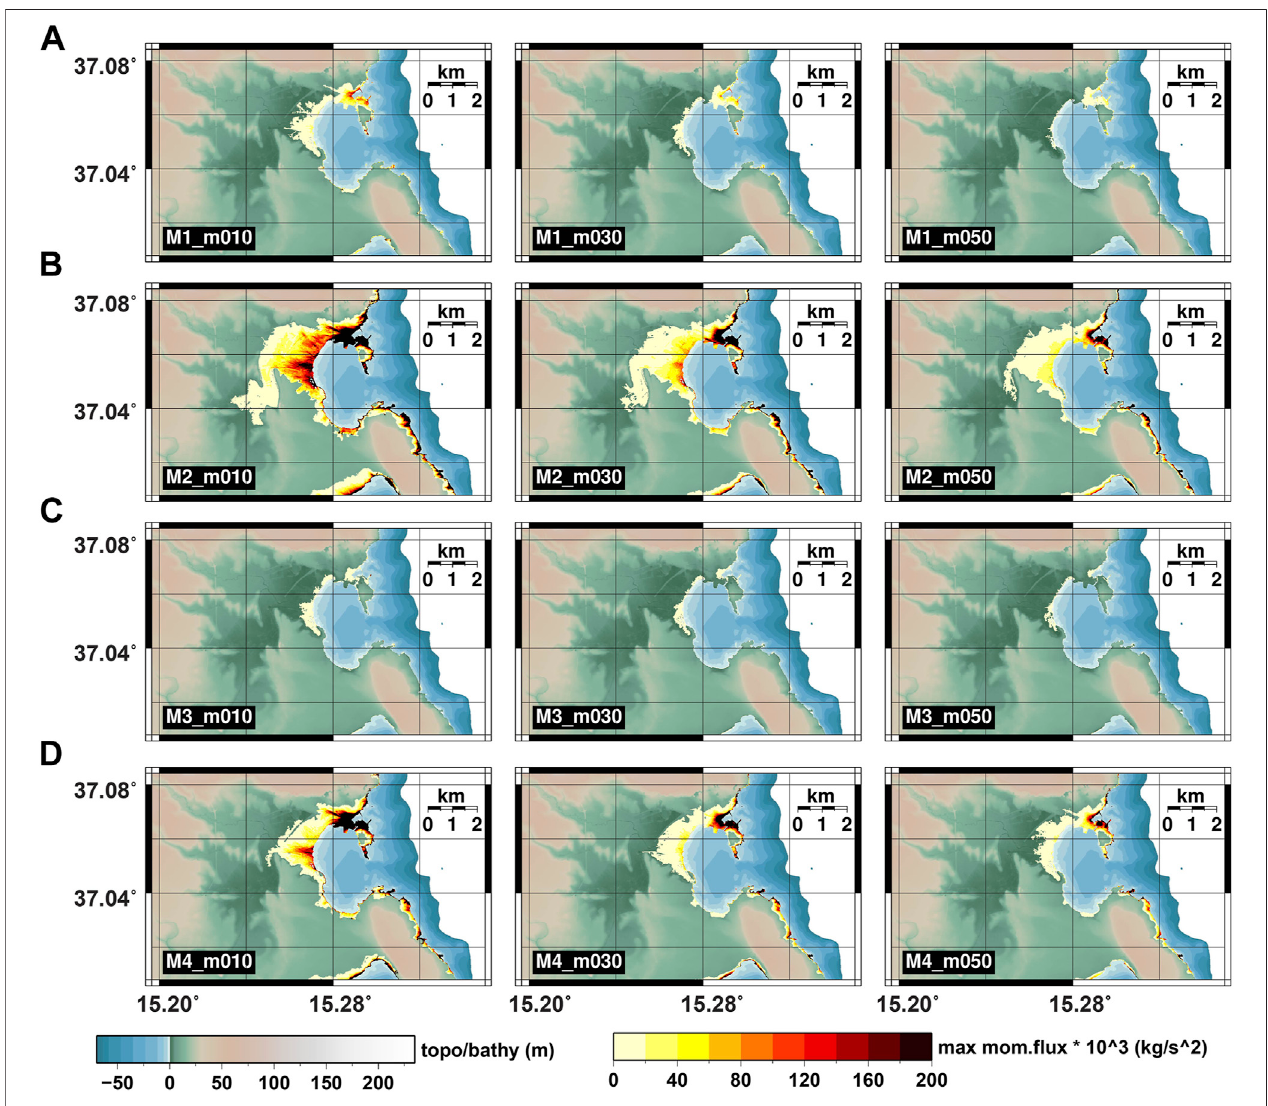
FIGURE 6 | Maximum momentum fl ux recorded as a function of position around Siracusa for earthquake scenarios M1, M2, M3, and M4 in panels (A – D) respectively. Each panel shows the results of the simulations with Manning friction values 0.01, 0.03, and 0.05 as indicated.